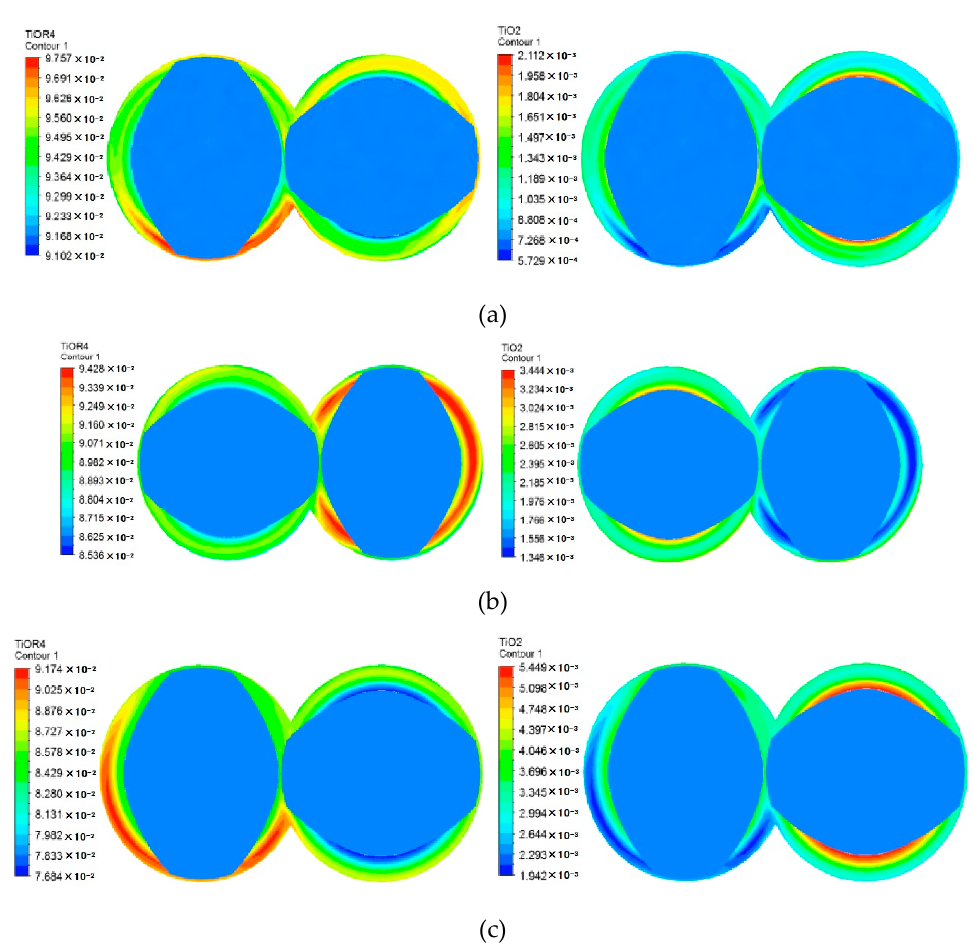
Figure 8. Concentration contours of reactant and product at different axial sections: ( a ) cross plane B1; ( b ) cross plane B; ( c ) cross plane B2.